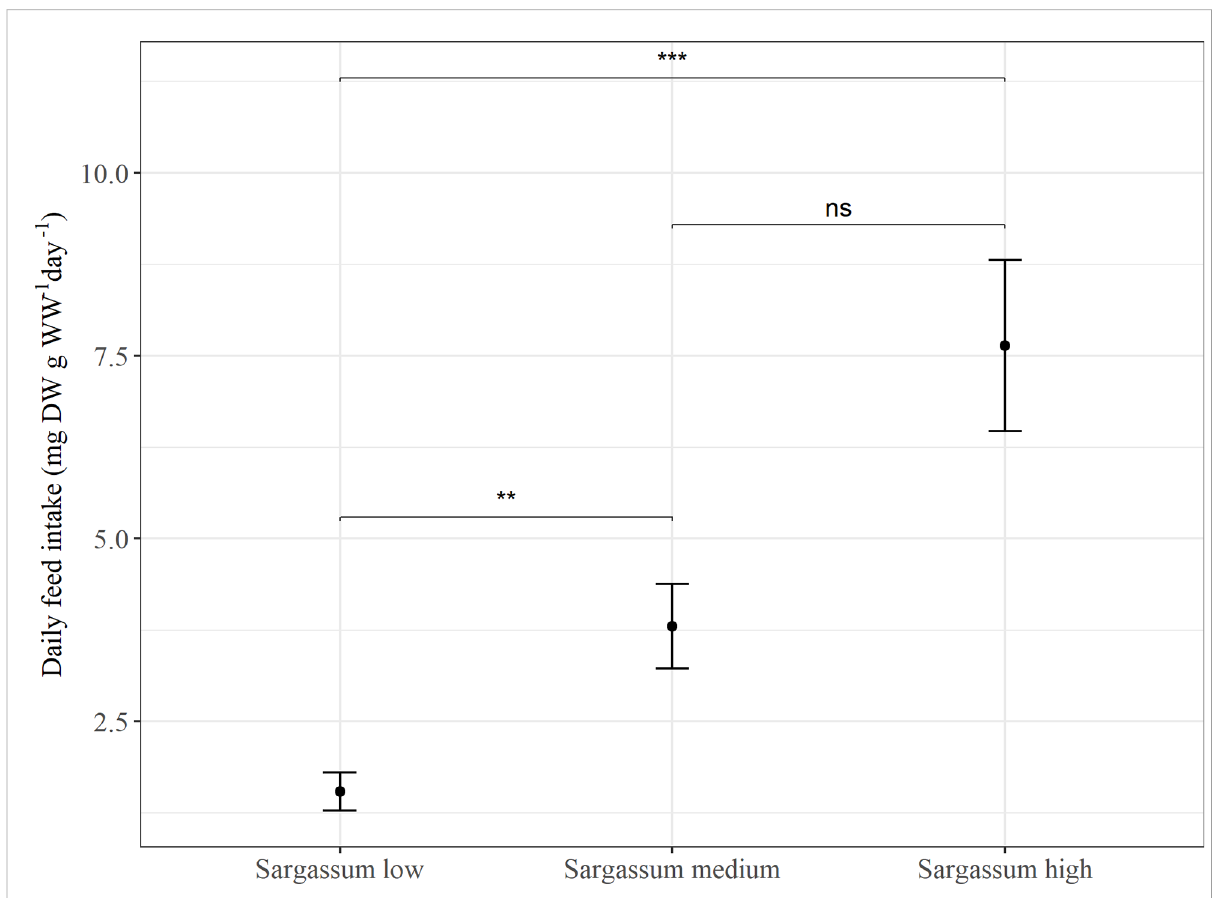
FIGURE 1 Average daily feed intake (mg DW g WW -1 day -1 ) in Experiment 1. P . tremulus (n=9) given feeds with three different levels of Sargassum powder (low: 25%, medium: 50% and high: 75% v:v) over a 10-day period. Error bars show standard error and signi fi cant differences between feeds are indicated with asterisks (ns, not signi fi cant; **: p ≤ 0.01; ***: p ≤